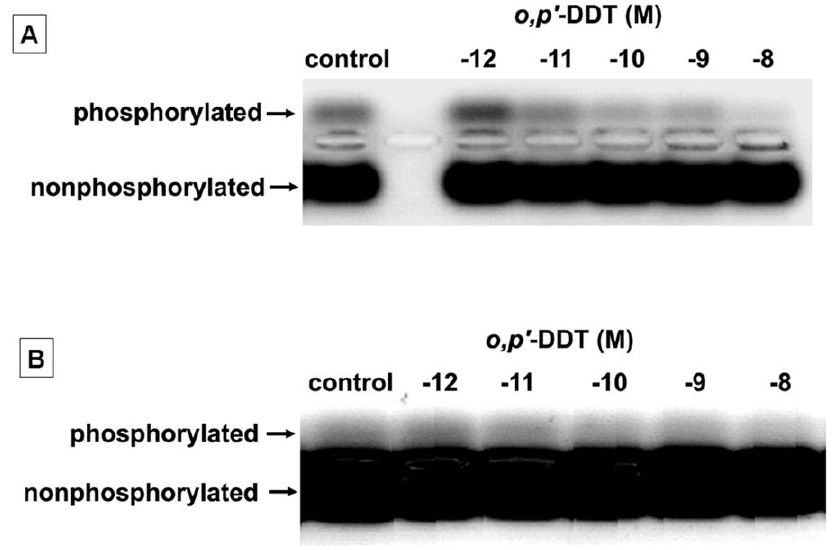
Figure 3. Low concentrations of o,p’ -DDT inhibit PKA but not PKC activity in primary cultures of rat ovarian granulosa cells. ( A ) PKA activity (phosphorylated band) in granulosa cells exposed to o,p’ -DDT at concentrations of 10 2 12 2 10 2 8 M. ( B ) PKC activity (phosphorylated band) in granulosa cells exposed to o,p’ -DDT at concentrations of 10 2 12 2 10 2 8 M. The data represented similar results from three independent experiments.